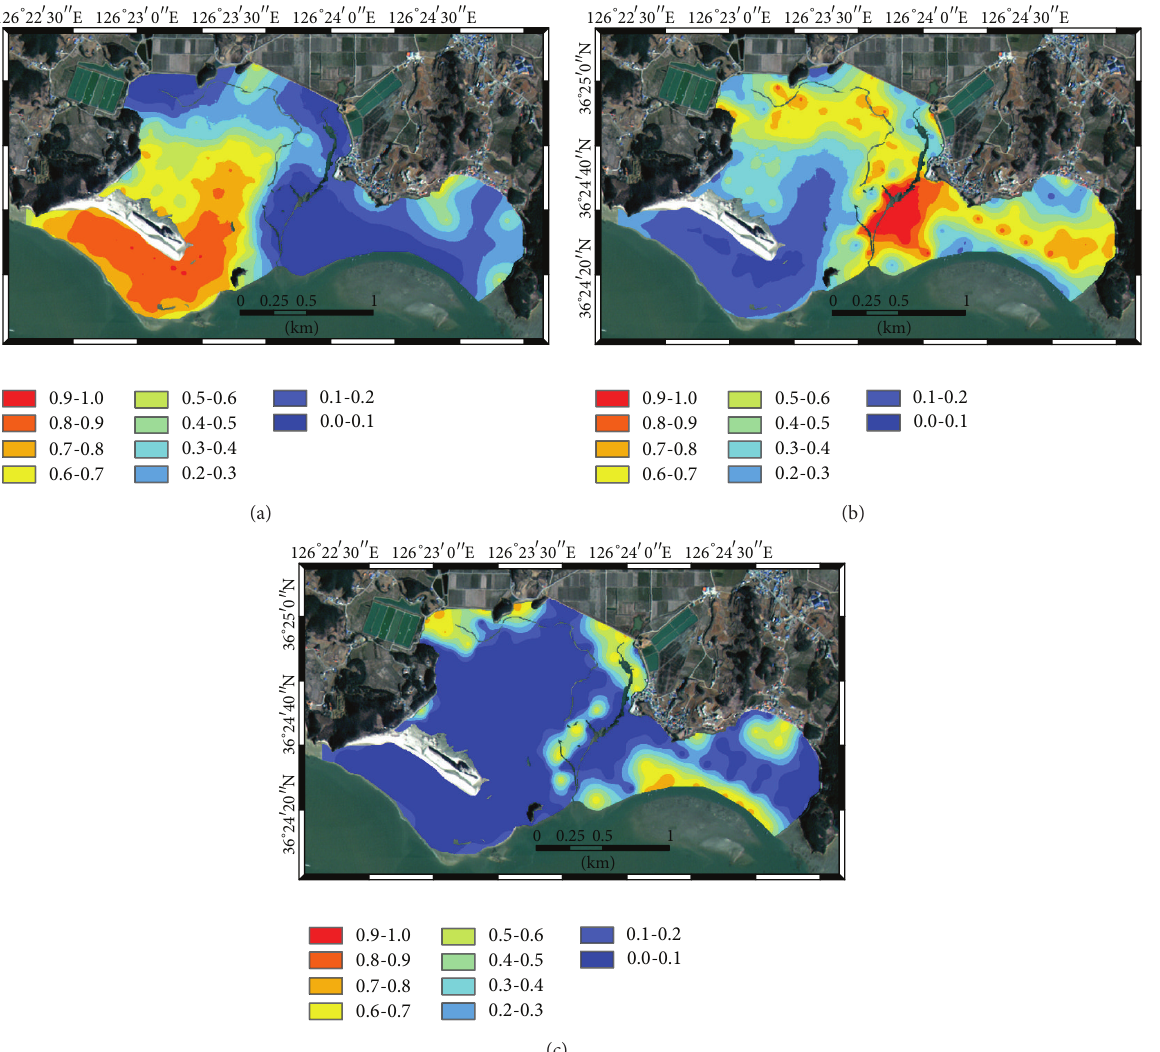
Figure 3: Conditional probability of each facies type prevailing over the study area by indicator kriging: (a) sand flats, (b) mixed flats, and (c) mud